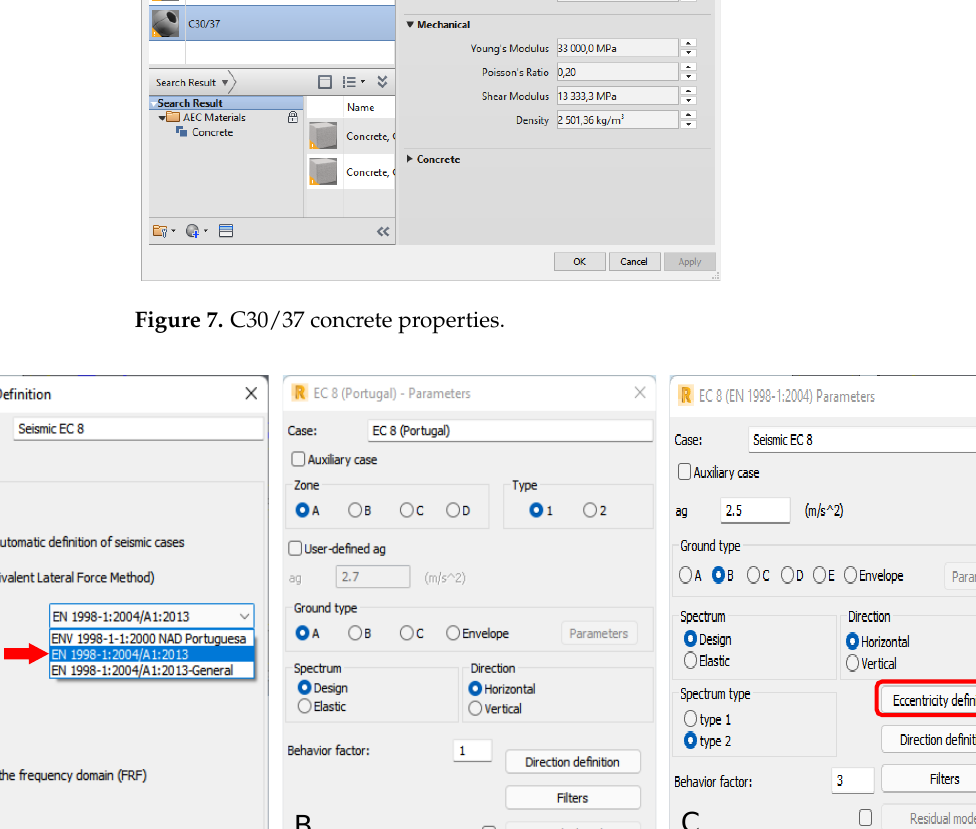
Figure 8. ( A ) Selected regulations; ( B ) Portuguese Standard NP ENV 1998-1-1 2000; ( C ) values adopted for seismic analysis.